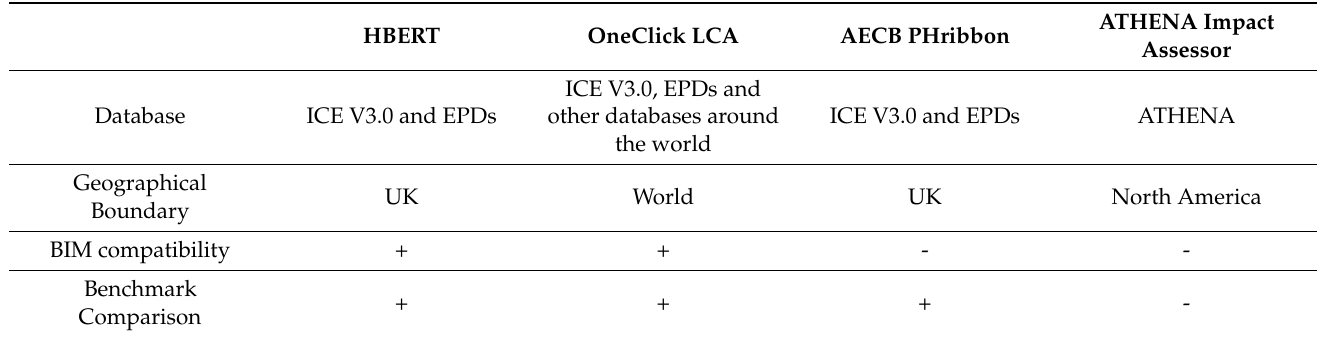
Table 1. Comparing different building LCA tools.